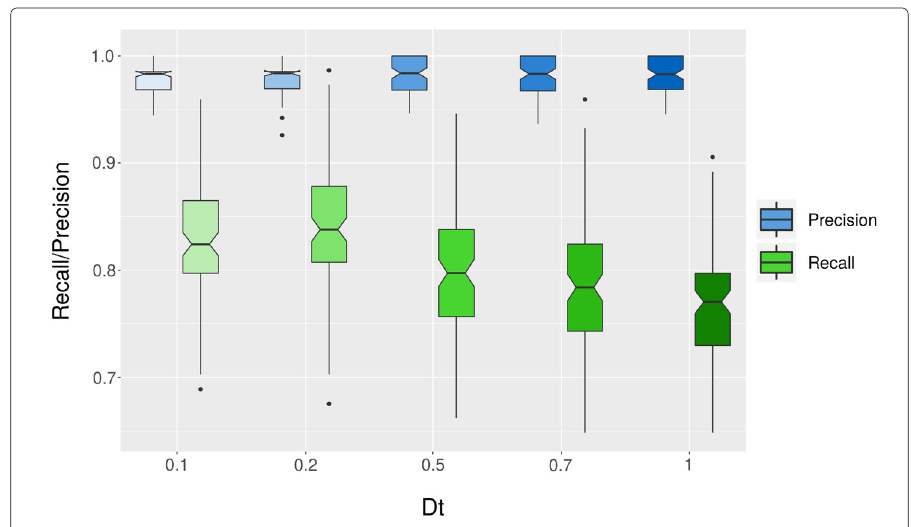
Fig. 4 Network reconstruction accuracy for different dt values. For each experiment included in the SHDP simulation study, the best reconstructed network selected by the inferential procedure has been compared to the true model configuration. Each replicate has been analysed by setting dt value to (0.1, 0.2, 0.5, 0.7, 1). Precision and recall values have been calculated considering only differentiation rates subjected to estimation (excluding λ i , j fixed to 0 due to hierarchical constraints) and measure the capability to correctly estimate absent differentiation paths, λ i , j = 0. Each boxplot corresponds to 100 independent precision/recall